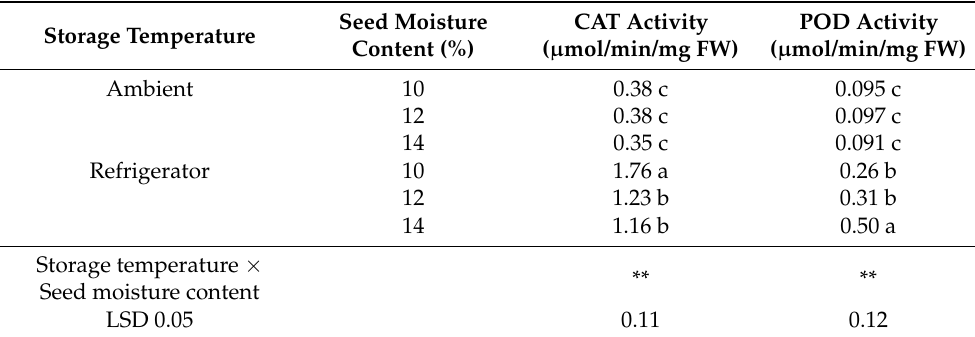
Table 4. POD and CAT activity of lablab bean seed after six months of storage under different storage